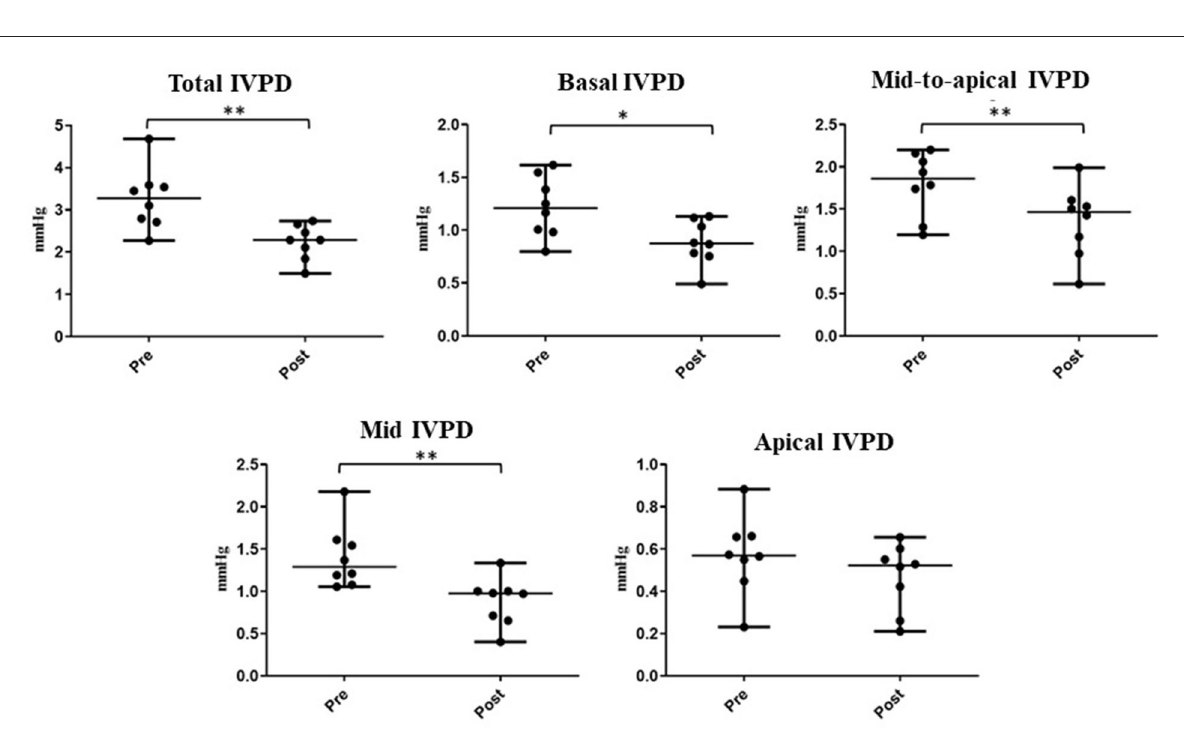
0.671; P = 0.005, 0.004, respectively) and significant adverse correlation with E/A ratio and deceleration time (r s = − 0.736, − 0.600; P = 0.001, 0.014, respectively). Mid-to-apical IVPG